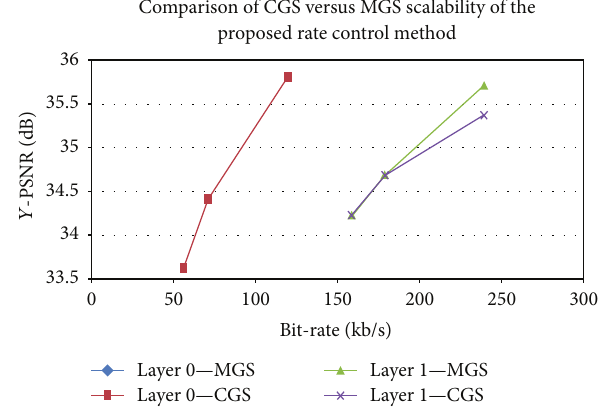
Figure 14: The CGS versus MGS comparison of the proposed adaptive bit-rate control method. The tested QP values for each layer are 30, 35, and